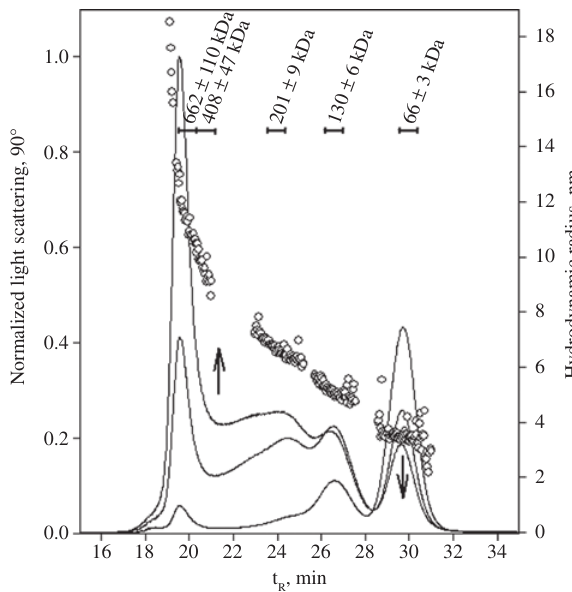
Figure 2: Chromatograms obtained using SEC-LS analysis of a solution of HSA irradiated in the presence of Ptr during different irradiation times (0 h, 1 h and 2 h). Circles represent the hydrody- namic radii of the molecules present in the sample after 2 h of irra- diation. The corresponding molecular masses at different retention times are indicated in the upper part of the figure. Reprinted from Reference [40] (Reprinted with permission from Biochemistry